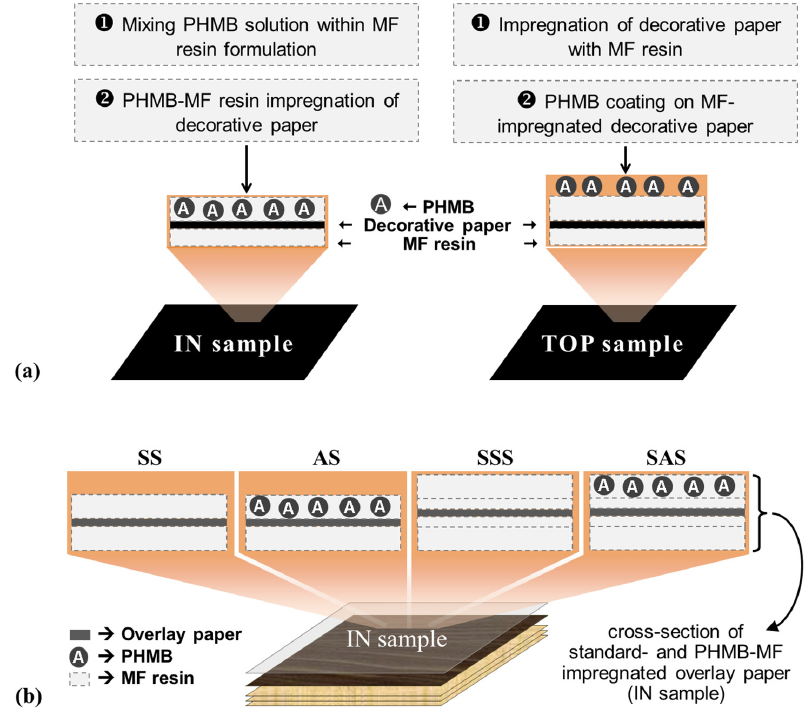
Figure 3. Schematic representation of HPLs containing PHMB: ( a ) decorative paper impregnation strategies; ( b ) build ‐ up approaches for HPLs without PHMB (SS and SSS) and with PHMB (AS and SAS). strategies; ( b ) build-up approaches for HPLs without PHMB (SS and SSS) and with PHMB (AS and